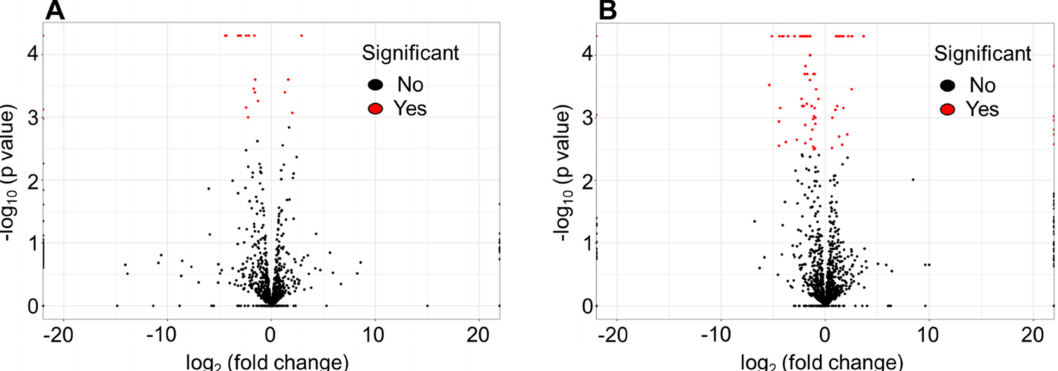
Figure 1. Volcano plots of the differential expression of genes in the presence of: ( A ) NaHCO 3 exposure alone; or ( B ) NaHCO 3 + 1 xMIC OXA co-exposures in NaHCO 3 -responsive strain MRSA 11/11. NaHCO 3 alone led to an observed 2 21 differentially expressed transcripts. NaHCO 3 and OXA co-exposures together yielded 84 differentially expressed transcripts. These numbers represent the total number of transcripts identified, featuring genes of both known and unknown functions. Table 1. Overview of gene functional classes altered ≥ 2-fold in two comparison groups, (Group